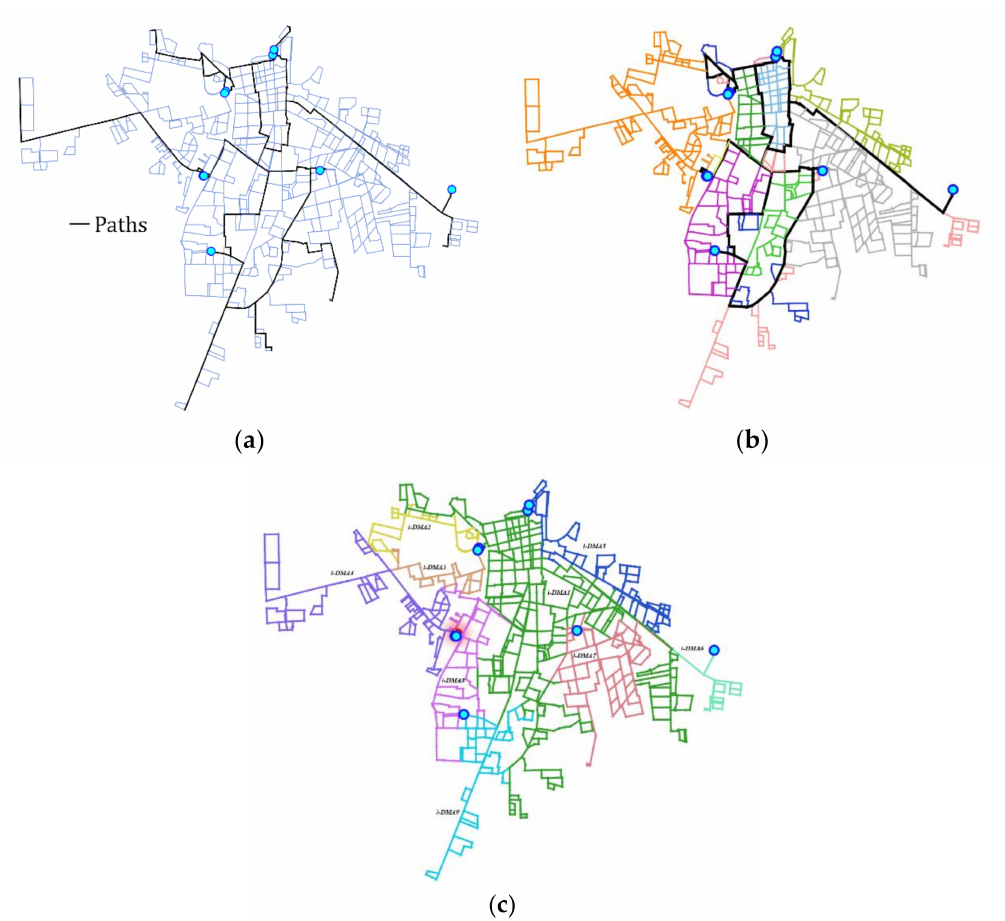
Figure 3. Matamoros network sectorization. ( a ) Flow paths. ( b ) Sectors by main network. ( c ) Sectors by source